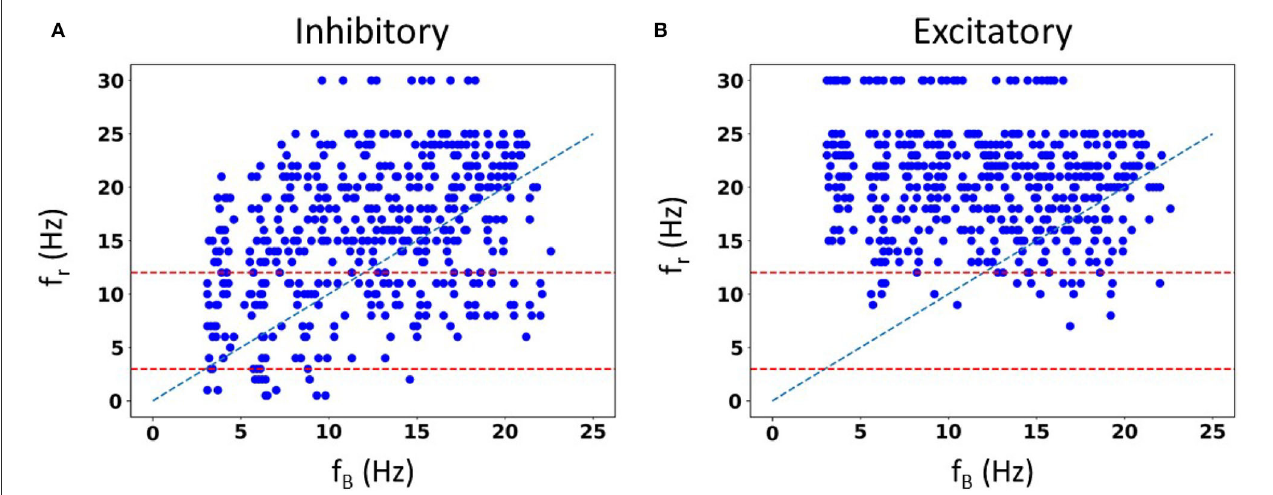
FIGURE6 Spike resonances using SINGLE. 500 IVL states generated from the 10 representative sets are used to plot resonant frequencies ( f r ’s) as a function of (average) baseline firing rates ( f B ’s). Plots are shown for inhibitory perturbations (A) or excitatory perturbations (B) . Diagonal line is where f r dashed lines delineate a theta frequency (3–12 Hz) range for the f r